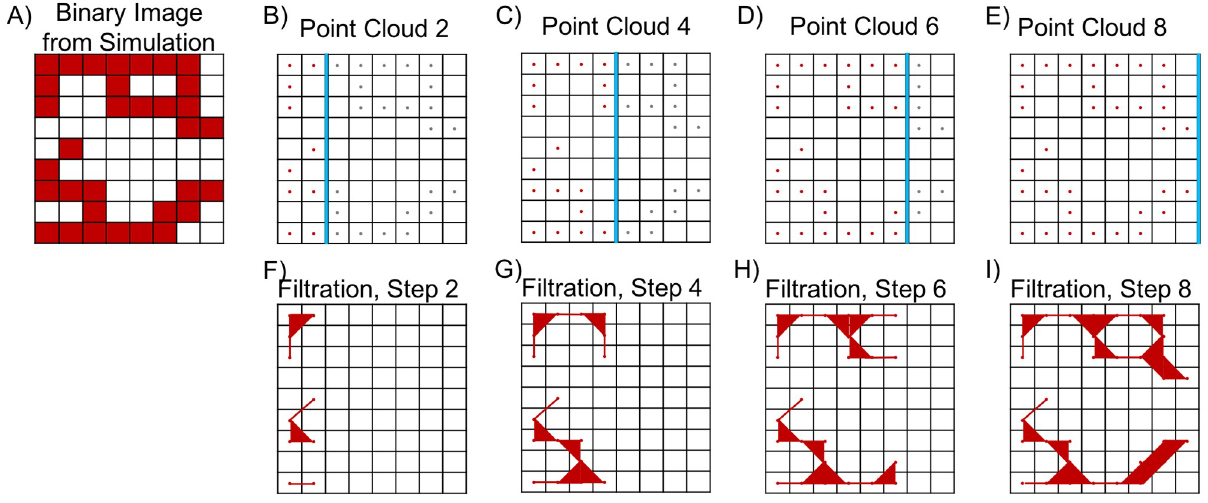
Fig 5. The LTR sweeping plane filtration for a binary image. A) Sample binary image from a simulation of the Anderson-Chaplain model. B-E) Point clouds used for each iteration of the sweeping plane approach. On each step, only pixels located to the left of the plane (denoted here with a blue line) are included; gray pixels are ignored. F-I) Filtration steps constructed from the point clouds in panels B-E.